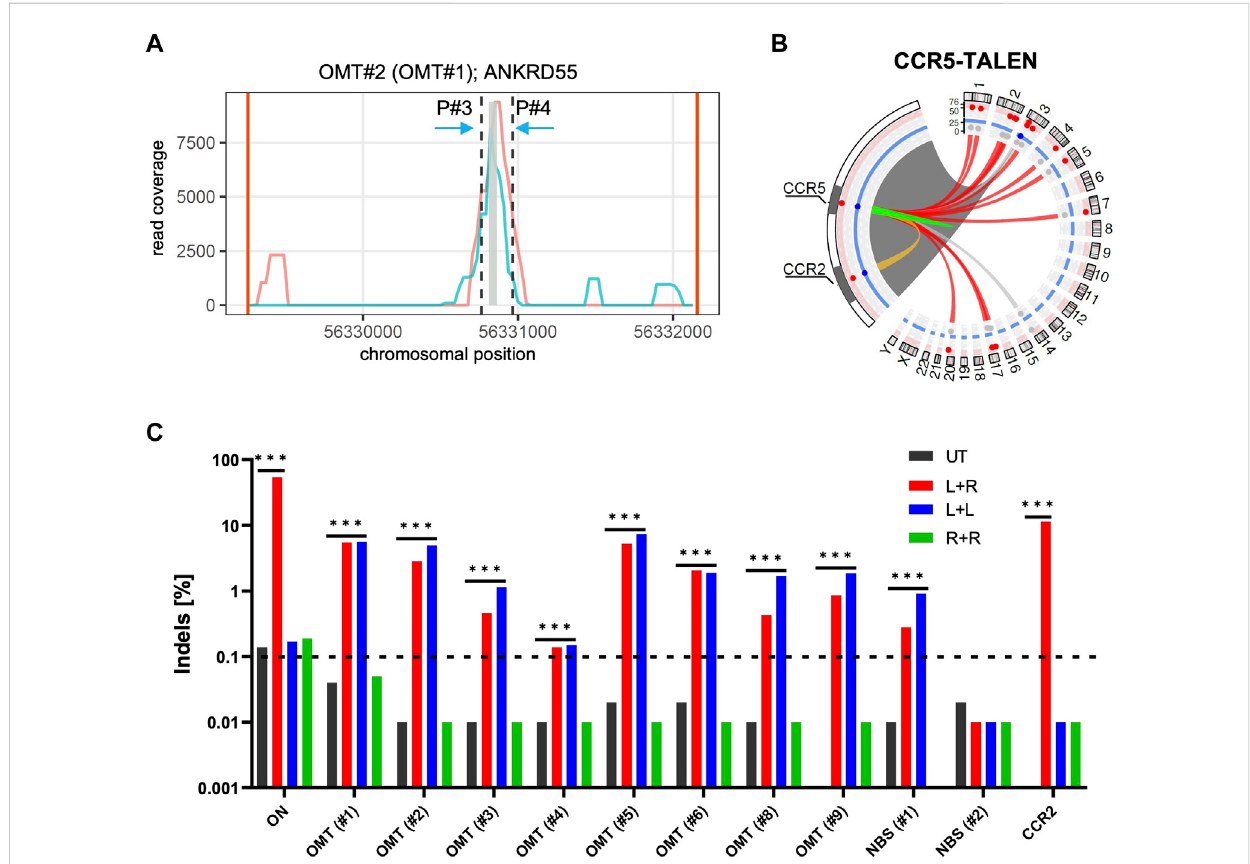
FIGURE 2 T-CASTanalysisfor CCR5 -targetingTALEN (A) Coverageplotfor ANKRD55 .Plotsshowingthecoverageoftworeplicates(turquoise,lightred)atthe OMT site in ANKRD55 . Black dashed lines indicate region (±100 bp) fl anking the bin with highest coverage (grey). (B) Structural variations. Circos plot illustrates T-CAST results with enlargement of the chromosome three region encompassing CCR5 and CCR2 loci. Lines represent chromosomal rearrangements with the CCR5 targetsite:OMTs with > 20 hits in red, NBSs with > 40 hits in grey, ambiguous classi fi cation (OMT/HMT) inyellow. (C) Genotyping. NGS at denoted sites was performed on untreated (UT) T cells, and T cells edited with a combination of left and right TALEN arm (L + R), just left (L + L) or just right (R + R) TALEN arms. *** speci fi es p -value < 0.001 (Fisher ’ s exact test, Bonferroni corrected p